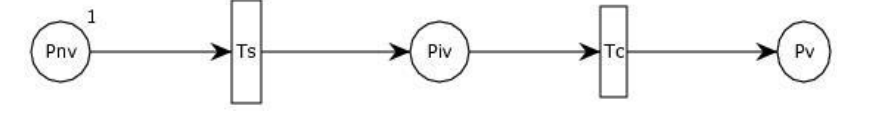
Figure 4. CPN Model of a City.